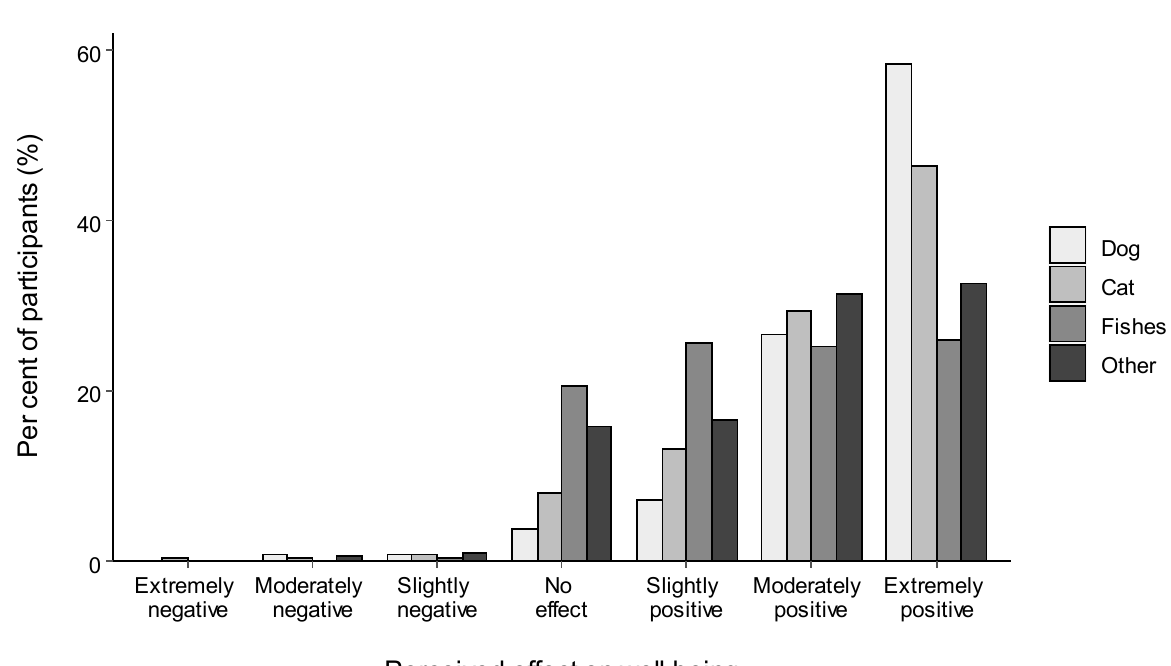
Figure 2. The percentage of participants who responded with each category across the scale by type of companion animal. ‘Other companion animal’ is inclusive of small mammals, exotic animals, birds and otherwise unspecified companion animals (e.g., horses). Dogs n = 661, cats n = 469, fish n = 218, and other companion animal n = 276.